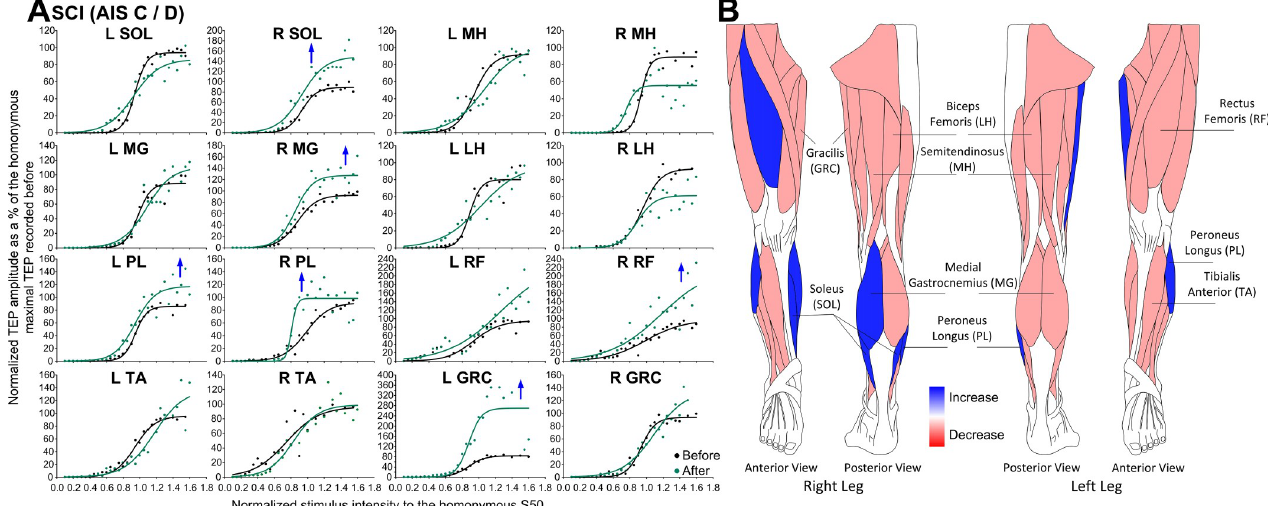
Fig 2. Transspinal evoked potential (TEP) recruitment curves before and after transspinal stimulation in AIS C-D. (A) TEPs normalized to the homonymous maximal TEP and plotted against normalized stimulation intensities to the S50-TEPmax obtained before transspinal stimulation training along with the sigmoid function fitted to the data. (B) Schematic representation of changes observed in the TEP recruitment input-output curves where red represents an increase and blue represents a decrease in the corresponding muscle from which the TEP was recorded. SOL: soleus; MG: medial gastrocnemius; TA: tibialis anterior; PL: peroneus longus; MH: medial hamstring; LH: lateral hamstring; RF: rectus femoris; GRC: gracilis. An asterisk indicates a significant difference before and after transspinal